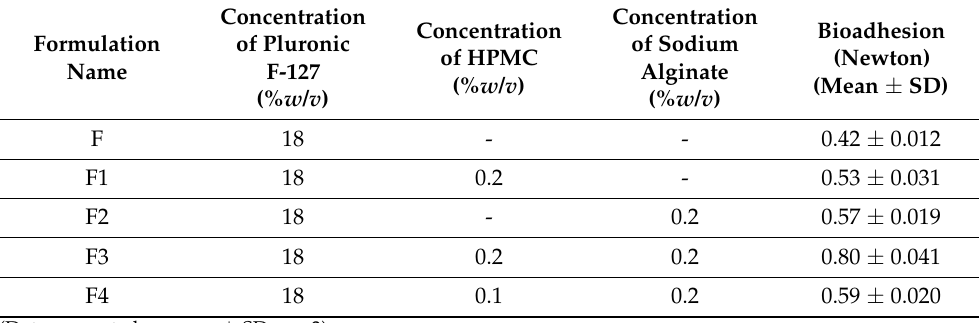
Table 4. Presentation of calculated ex vivo bioadhesion results of different formulations. Formulation